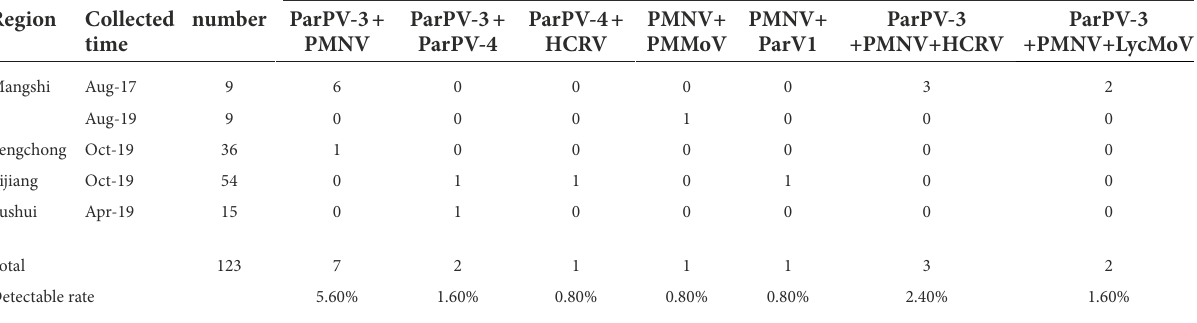
TABLE 2 Co-infection of viruses in P.